Question: Condense the content of this figure into a single sentence.
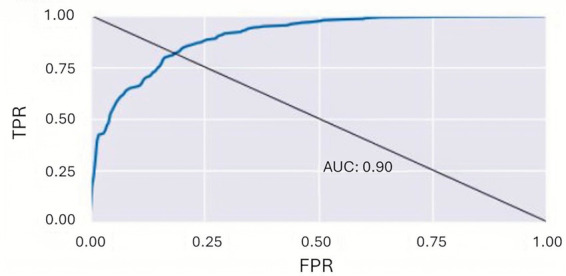
Answer: Strong AUC of 0.9 for discriminating 5 diopters based on the clinical threshold for vertical misalignment.